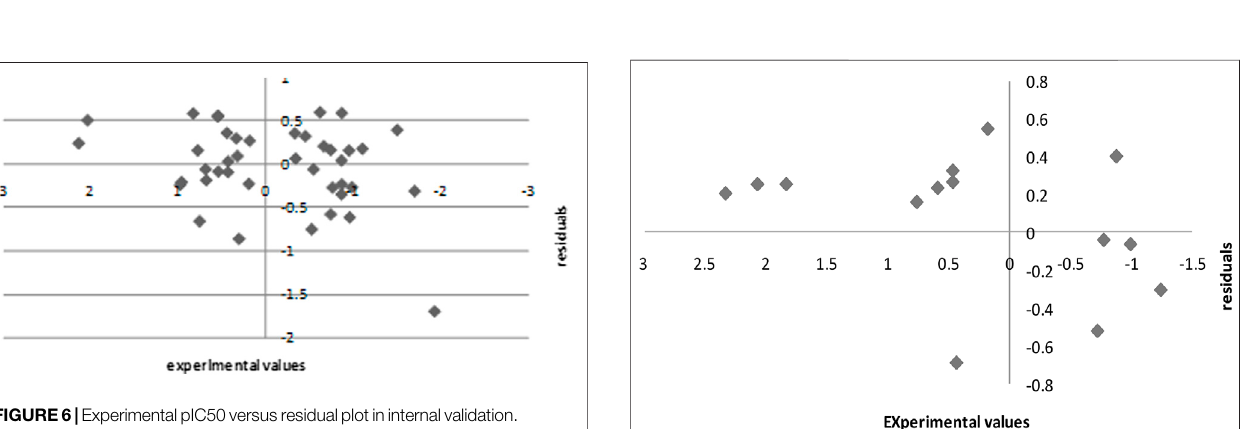
FIGURE 5 | Experimental pIC50 versus calculated pIC50 plot in internal validation.